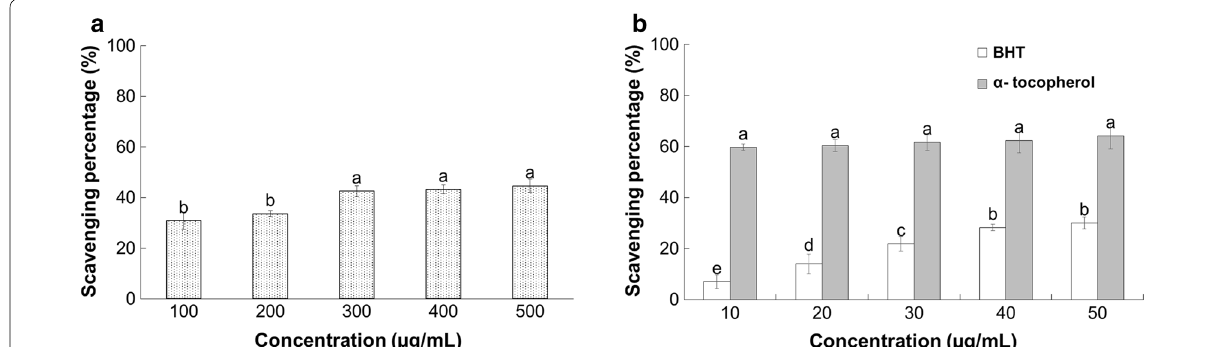
Fig. 2 DPPH radical scavenging potential of a Porphyra tenera volatile oil (PTVO) and b BHT and α‑tocopherol as the reference compound. Different superscripts in each column indicate significant differences in the mean at P <